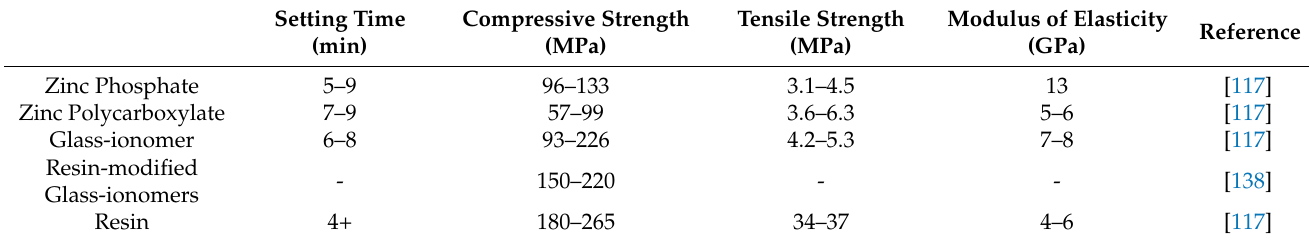
Table 2. Mechanical properties of various luting